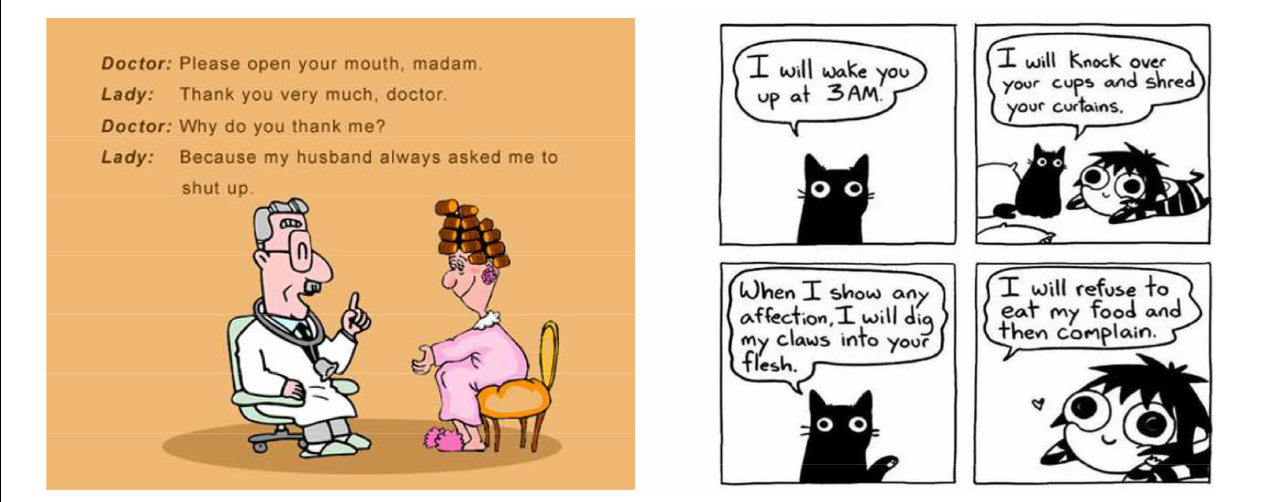
FIGURE 1 | Caricature representation. Reproduced with permission from (Merriam-Webster), available at (https://www.merriam-webster.com/dictionary/caricature).